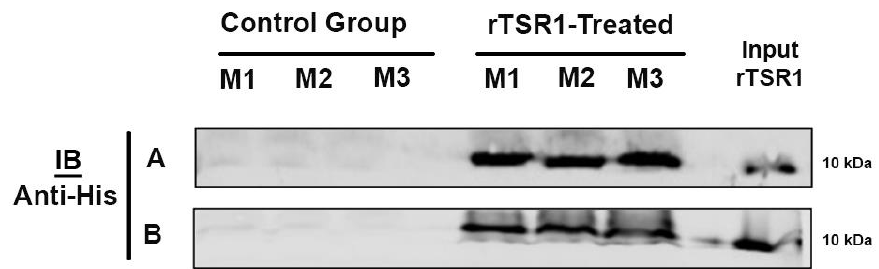
Figure 6. IP-injected rTSR1 reached the tumor. Immunoblot of serum and tumor lysate displayed band at ~10 kDa, corresponding to the molecular weight of rTSR1. The band is observed both in serum ( A ) and with the whole tumor lysate ( B ) from mice that received rTSR1 only. The rTSR1 input is used as the positive control. M1 to M3 refer to mouse 1 to mouse 3.